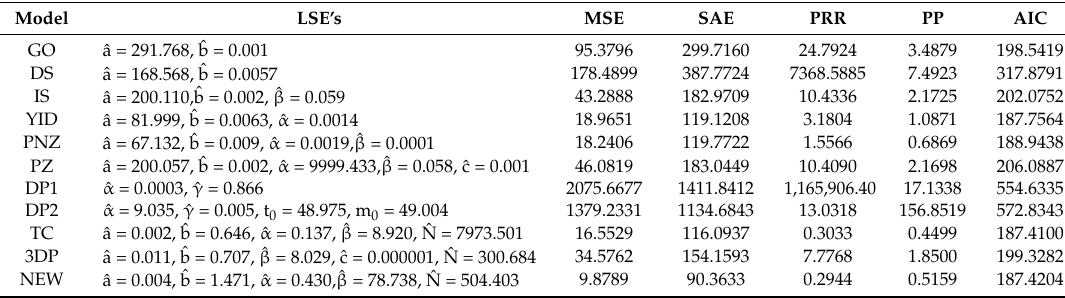
Table 5. Model parameter estimation and comparison criteria from Dataset